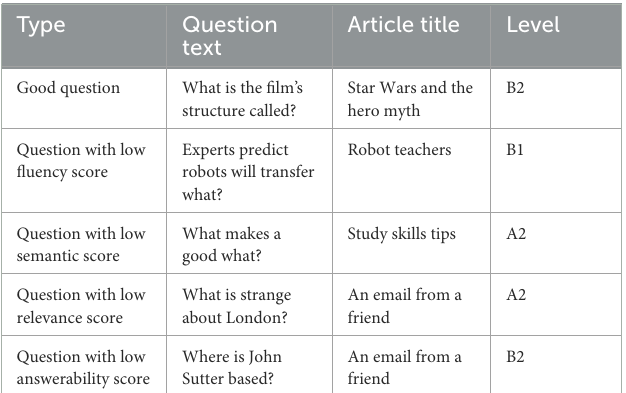
TABLE 5 Sample of good and bad